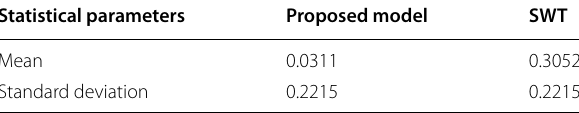
Table 8 Statistical analysis of model prediction